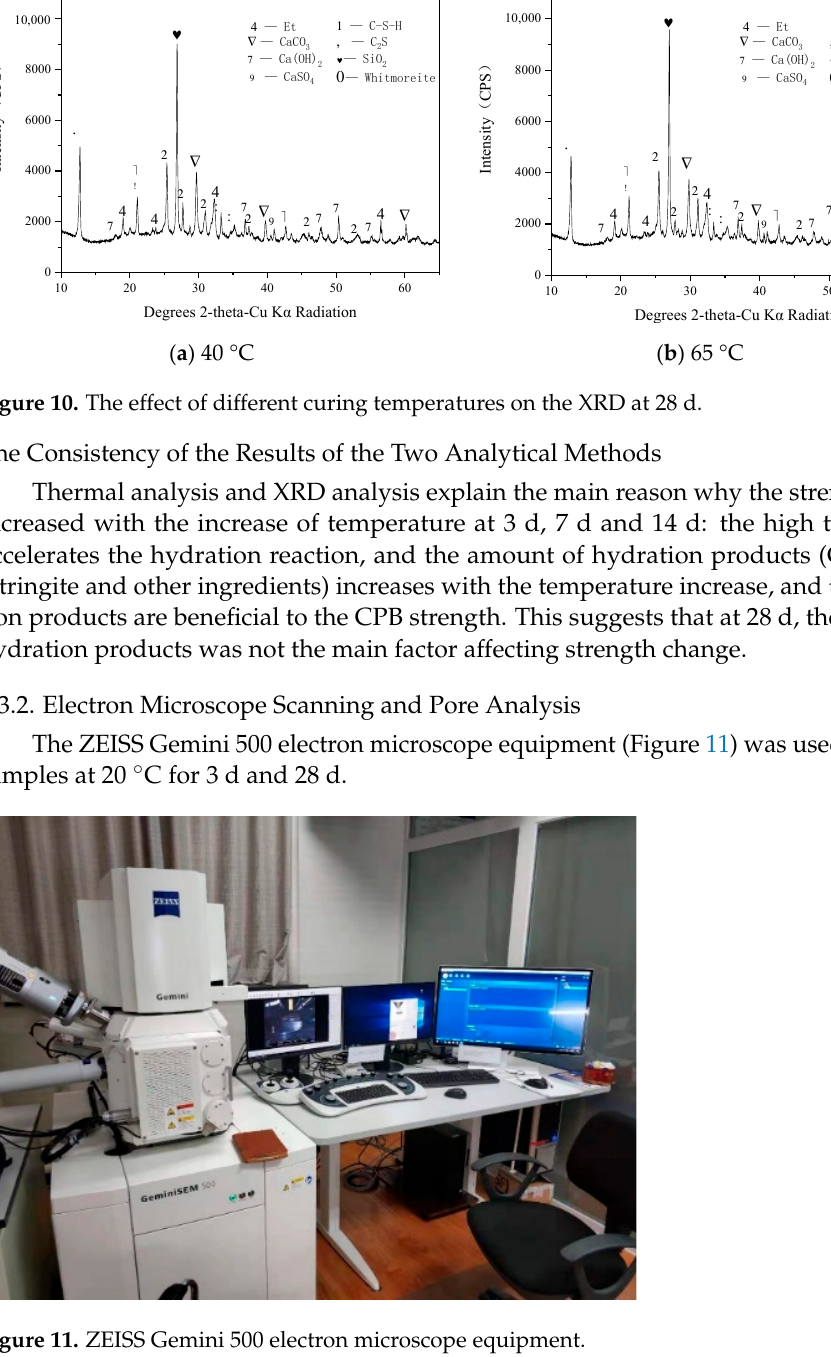
( b ) ×2000 Figure 12. SEM images of CPB at different magnifications (20 °C and 3d). Figure 13 shows the SEM images of the samples after curing for 28d at 20 °C and 50 °C . Comparing the electron microscope images at 20 °C for 3d and 28d (Figures 12a and 13a), it can be observed that the pores between tailings particles are filled by hydration prod- ucts at 28d, and the structure is more compact, which leads to greater strength. Compared with the SEM images (28d) at 20 °C and 50 °C , it can be seen that there are many coarse pores in the sample at 50 °C , and the structure is less dense than that at 20 °C . This may be the reason why the strength (28d) at 50 °C is lower than that at 20 °C . In order to verify the conjecture on the cause of the strength change, pore analysis was carried out for the above phenomenon. In this paper, the samples’ cross-sections were scanned by electron microscope, and the SEM images were processed with Photoshop and Image Pro Plus software to obtain the microstructure information and the change rule of pore.